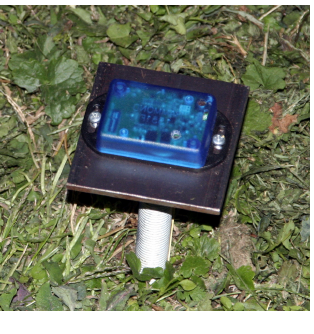
Figure 5. The sensor node.